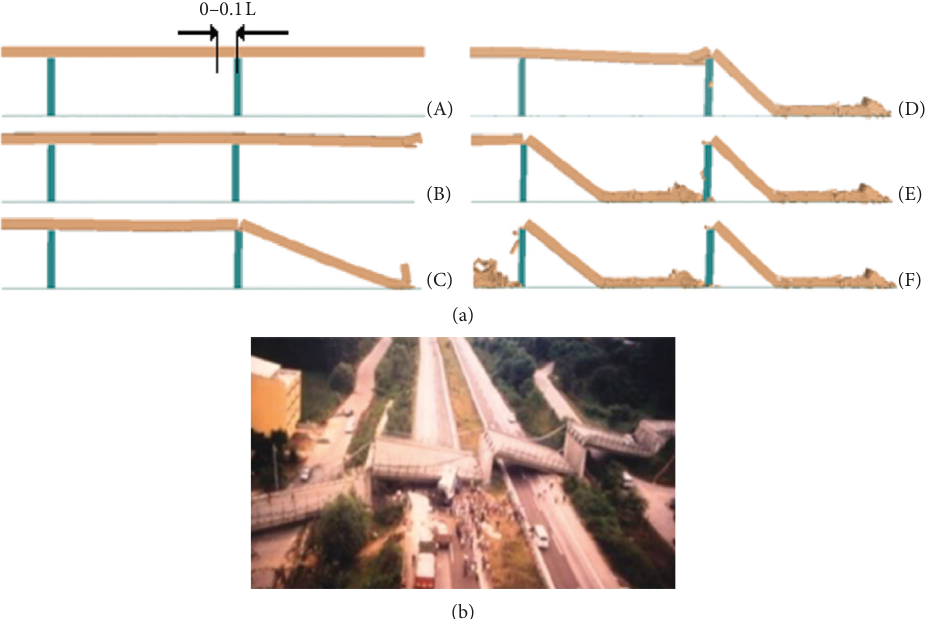
Figure 15: Second type of progressive collapse of bridges (a) in analysis: (A) stable condition, (B) initial crack at the connection of deck and abutment, (C) falling down of the first span deck on the ground and large rotation of deck at pier bearing, (D) fracture of adjacent span at distance of 0–0.1 L (E) the same mechanism occurring for adjacent span, and (F) propagation of collapse in the bridge; (b) in